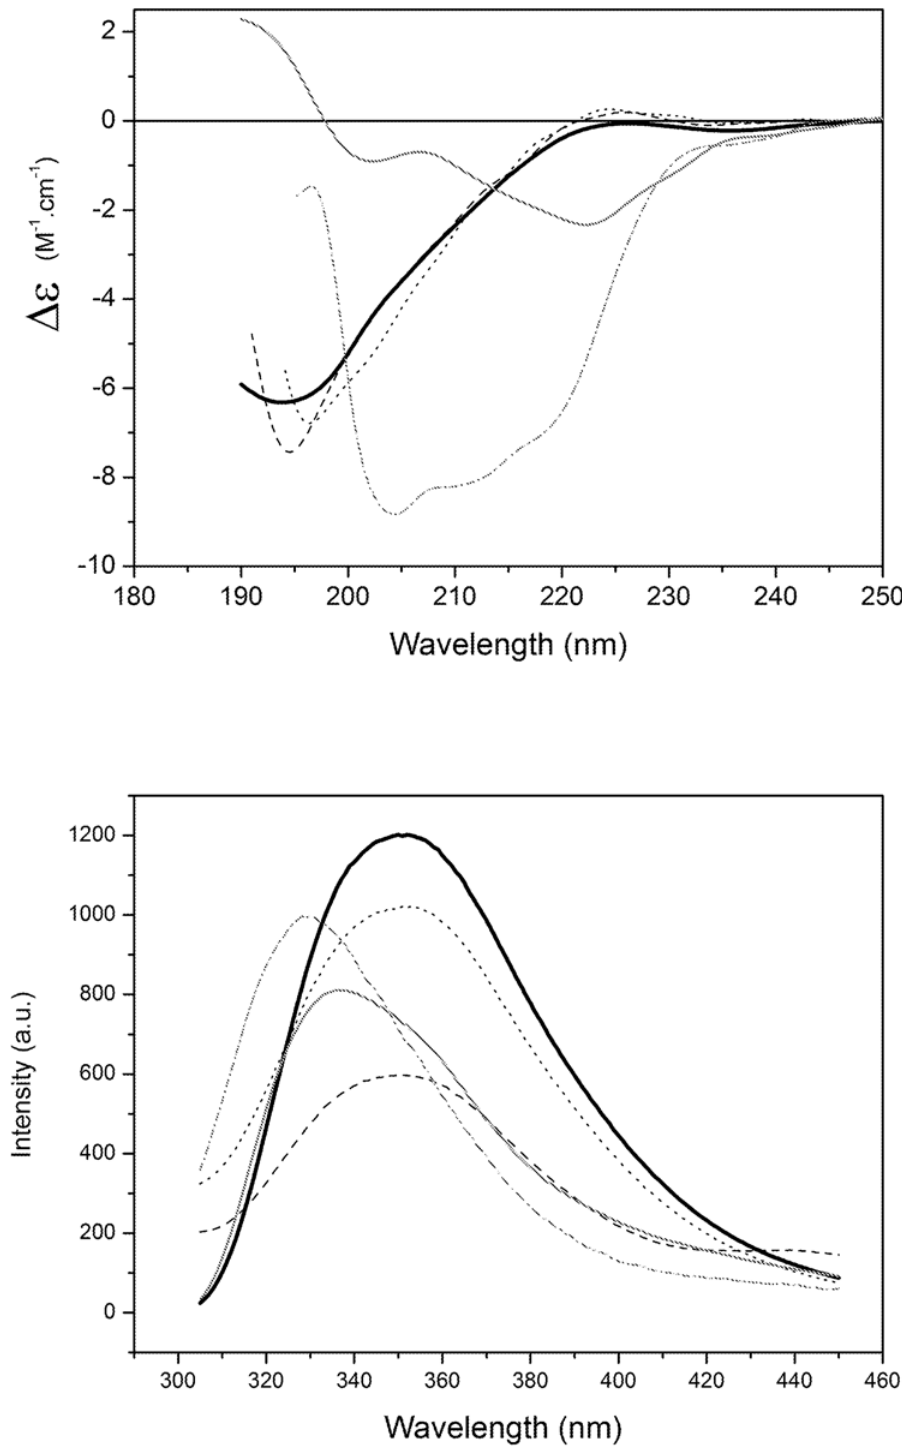
Fig 3. Interactions of the Sit2 peptide with different types of model membranes. a) CD spectra of Sit2 in aqueous solution (black) and in the presence of LUVs composed of different phospholipids (DPPS (dash), DPPC (dot), POPA (grey), and DPPG (dash dot grey)). b) Fluorescence spectra of Sit2 in aqueous solution (black) and in the presence of the different LUVs.